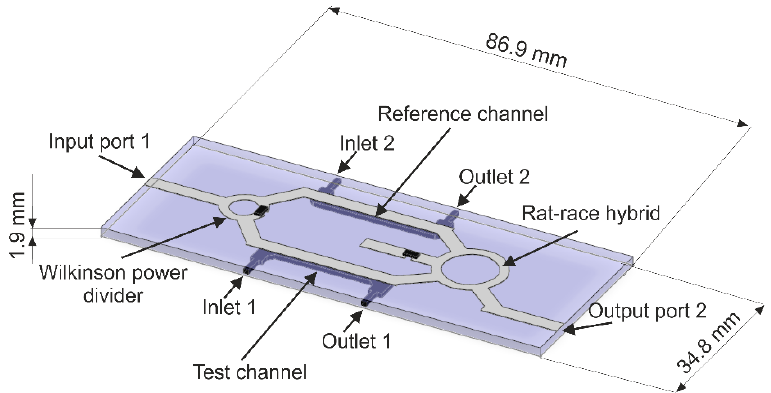
Figure 3. A CAD model of the coupler-based sensor.